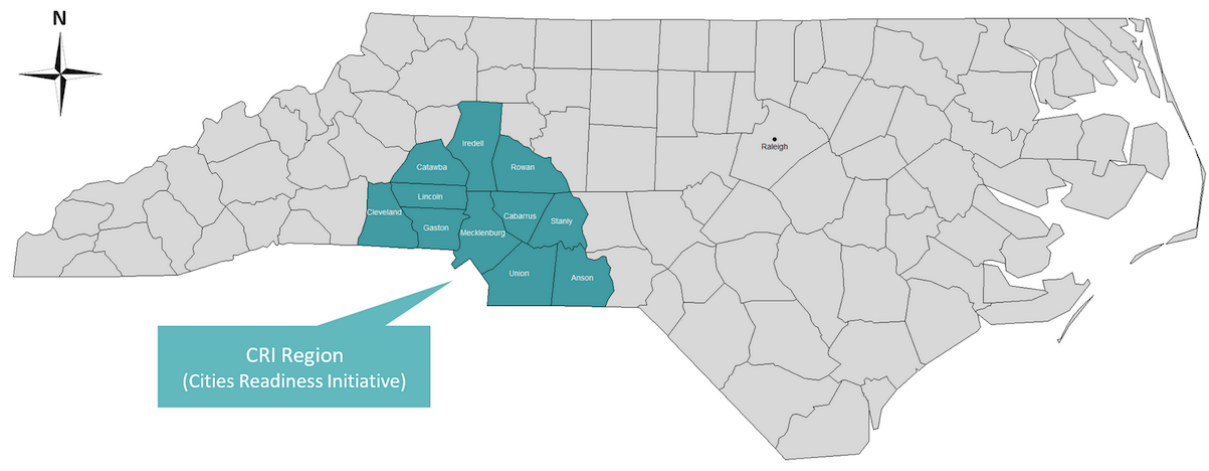
Figure 1. Map of North Carolina showing the Cities Readiness Initiative region.